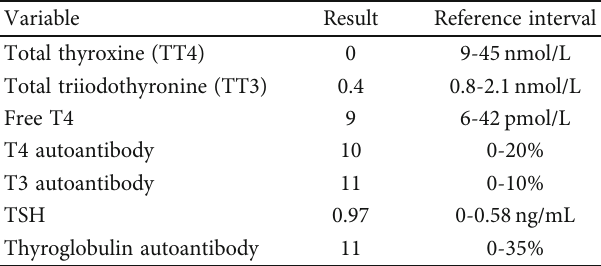
Figure 2: The dog in the ICU with a nasogastric tube (NGT) in place. Note the “ tragic ” facial expression. Table 3: Thyroid panel